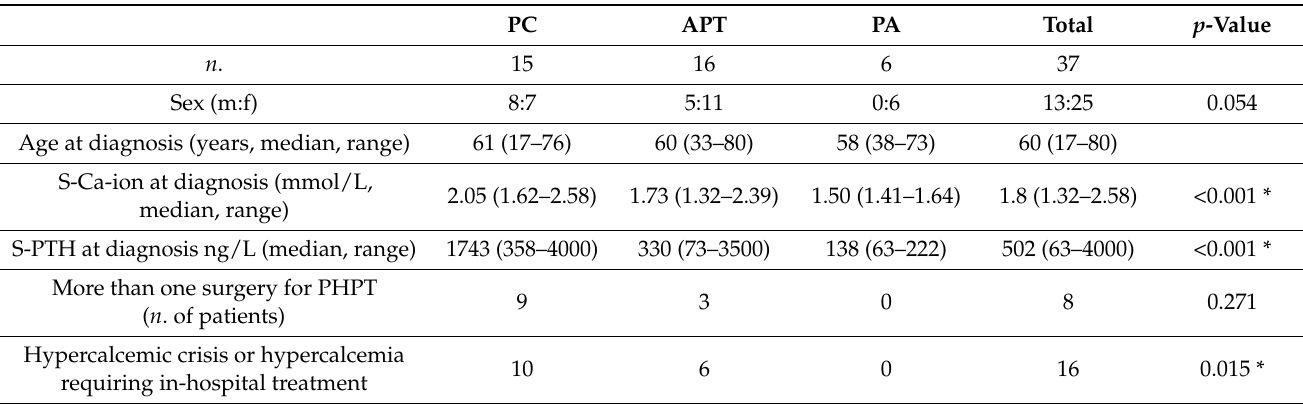
Figure 1. Flowchart of PRUNE2 germline mutation screening in patients with parathyroid tumors. The whole exome sequencing (WES) was performed from normal DNA. After WES analysis, the variant calls were filtered to have MAF < 0.05. Mutation consequences were assessed using pathogenicity predictor software and the ClinVar database. Five potentially deleterious PRUNE2 mutations were identified, distributed among seven PHPT patients. PC = parathyroid cancer; APT = atypical parathyroid tumor; PA = parathyroid adenoma; MAF = minor allele frequency. The patient characteristics are shown in Table 1. Table 1. Characteristics of the patient cohort.